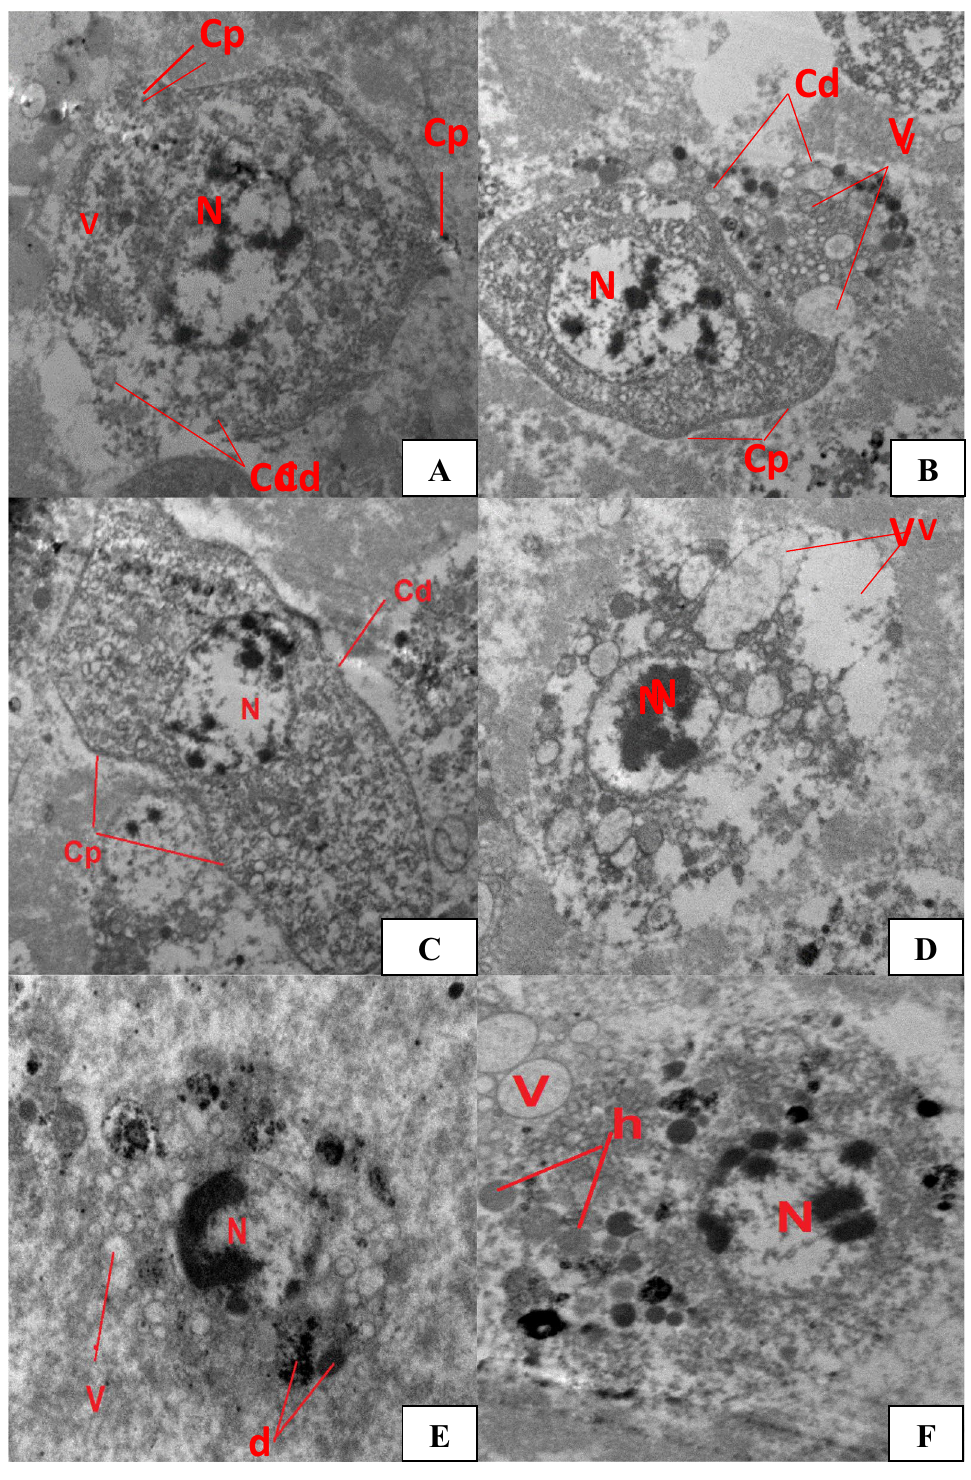
Fig. 4 Electromicrographs of the ultrastructure of hemocytes of fully developed larval instar of Corcyra cephalonica in irregular physiological conditions. A Prohemocyte; B , C : Plasmatocytes; D : Granulocytes; E : Spherulocytes; F : Oenocytoids. with Nucleus (N) and Mitochondria (MI), Electron Dense Granules (d), Vacuole (v); Cytoplasmic projections (Cp); Cell Membrane degenerated (Cd); heterogeneous granules (h). Scale bar represents 500 nm ( A , B , C , D , F ) and 100 nm ( E